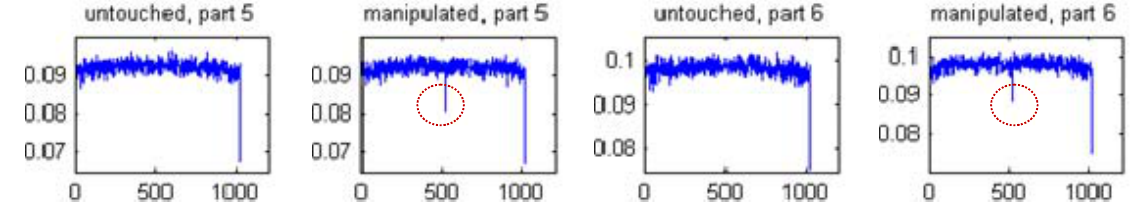
Figure 4. The SRSC features extracted from an original AAC audio file and from manipulated AAC audio file (doctoring in the middle).